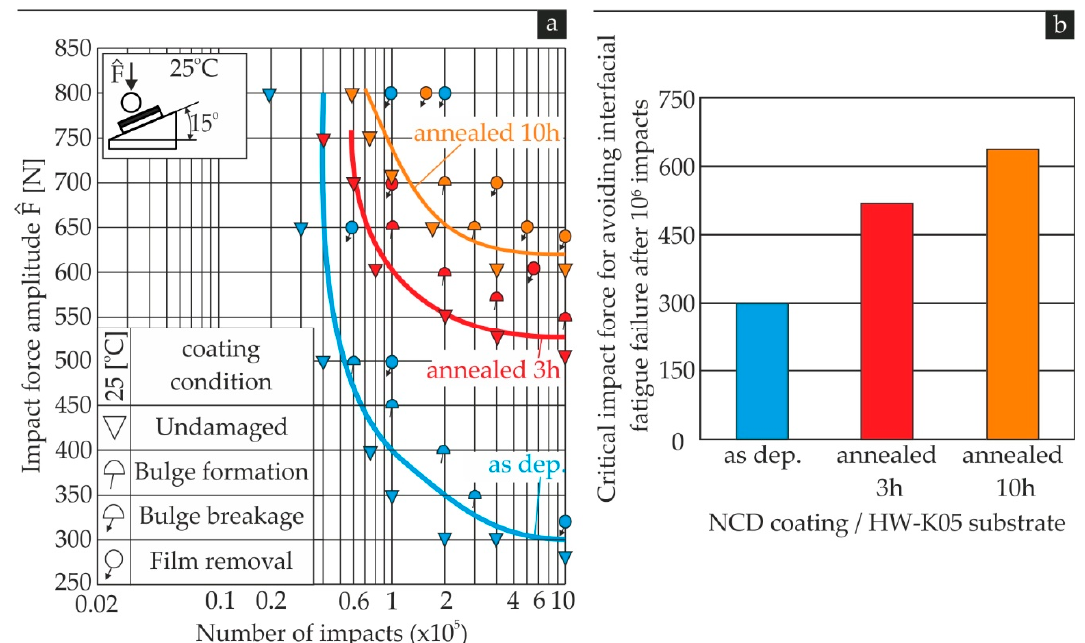
Figure 10. ( a ) NCD coating status after inclined impact tests at different combinations of impact load and number of impacts; ( b ) critical impact forces for avoiding interfacial damage after 10 6 impacts in the examined coating cases.